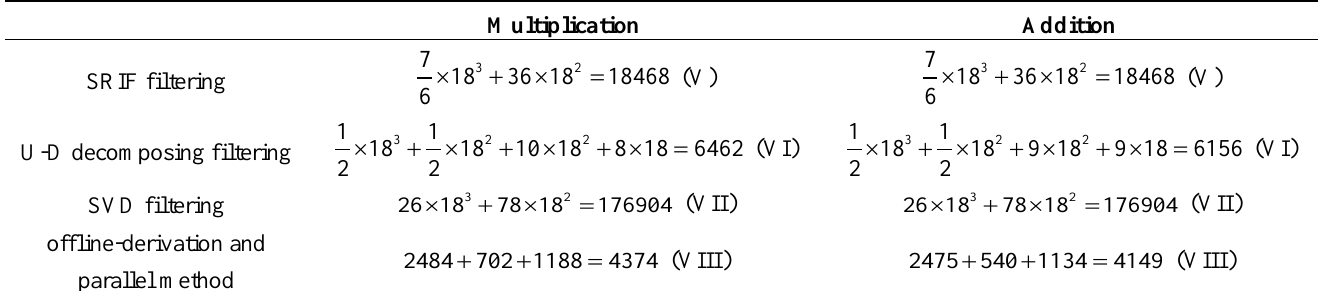
Table 8. Comparison of offline-derivation & parallel method and general optimization